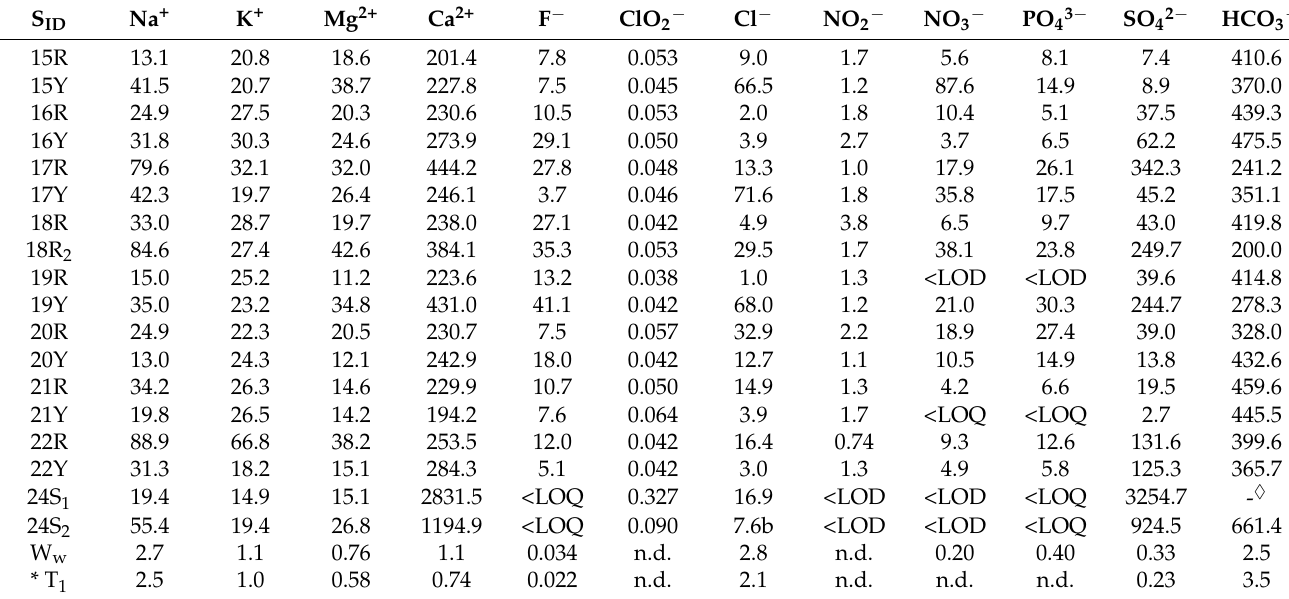
Table 2. Chemical composition of sampled bricks (mmol/kg) and water (mmol/L). The bicarbonate value was theoretically determined. The obtained RSD was below 5% in all